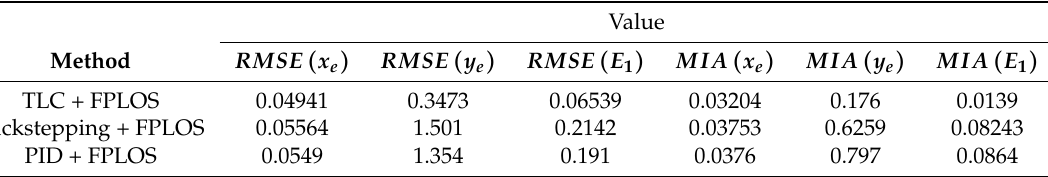
Figure 16. Cross-track errors y e . Table 2. Performance comparisons of different